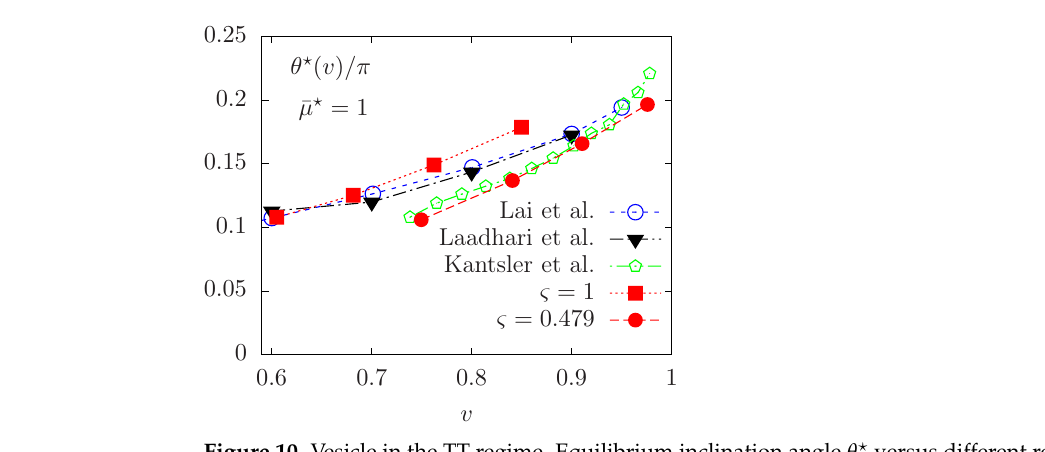
Figure 10. Vesicle in the TT regime. Equilibrium inclination angle θ (cid:63) versus different reduced areas v . Comparison with the experiments in [51] and numerical results in